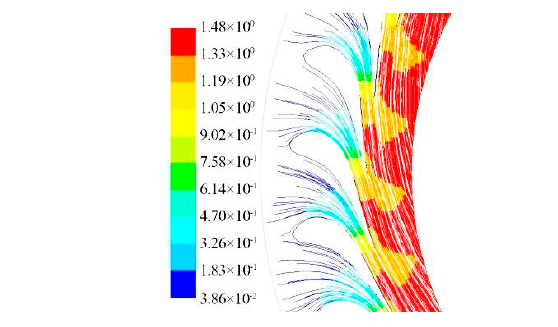
Figure 11. Average outlet temperature and velocity of stator with an installation angle of 28°.